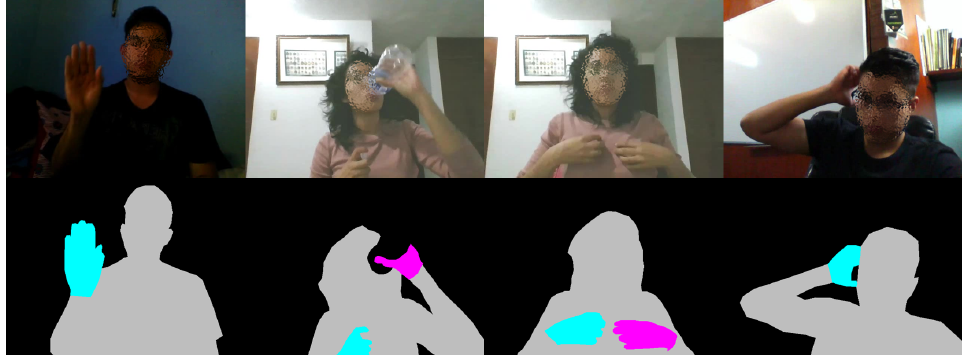
Figure 7. Example of the pixel-level annotations on non-gesture frames. Top row: original RGB frames. Bottom row: pixel-level annotations, gray=person, cyan=right, magenta=left